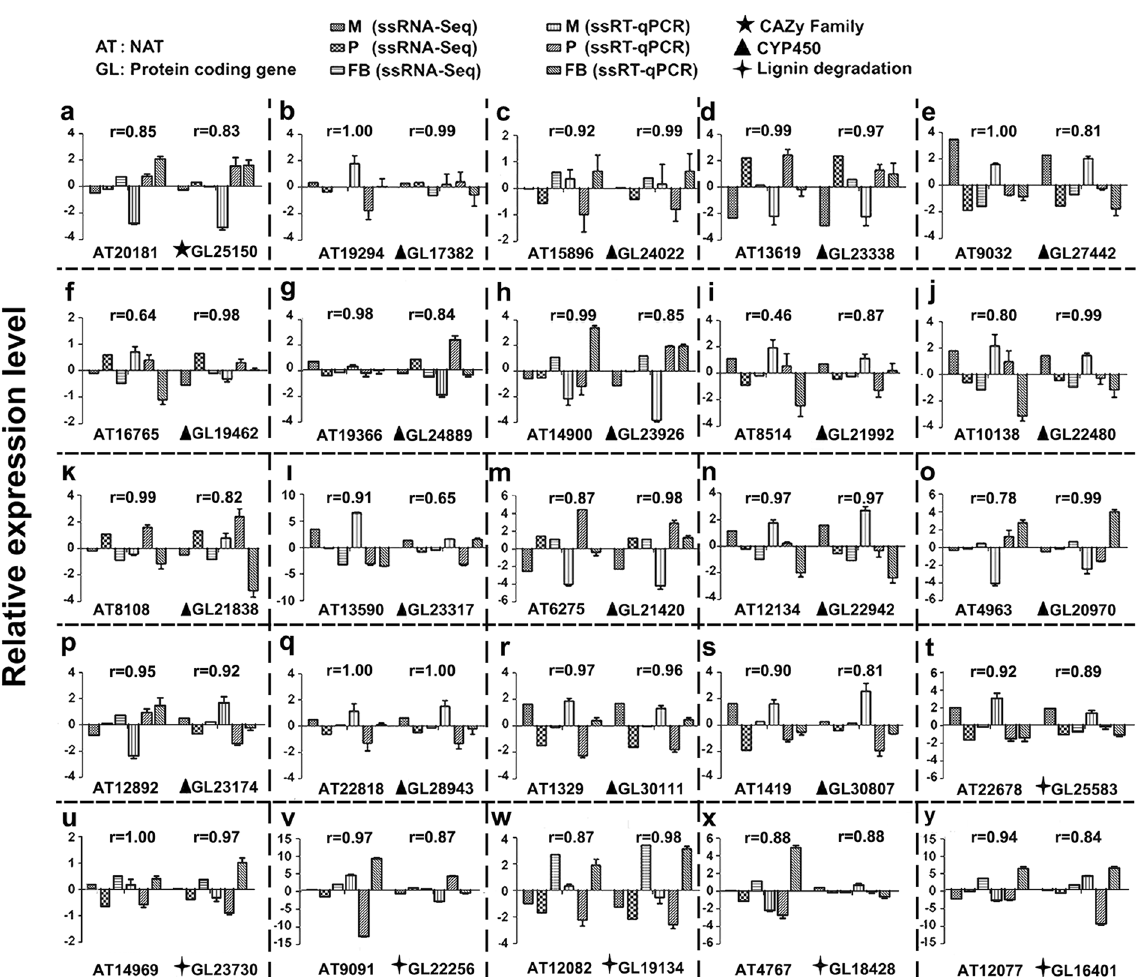
Figure 3. Validation of ssRNA-seq results with ssRT-qPCR experiments. Twenty-five SAT pairs were selected and subjected to ssRT-qPCR analysis. The expression levels obtained from the ssRNA-seq and ssRT-qPCR experiments for these SAT pairs are shown in panels a-y respectively. For results from both experiments, the expression levels at each developmental stage were normalized to the mean expression levels across the three stages. In each panel, the names of the NAT and ST are shown at the bottom. The X axis indicates the conditions under which the expression levels were measured, including the developmental stages and technologies. The Y axis indicates the relative expression levels obtained from the ssRNA-seq and ssRT-qPCR experiments. The error bar for the ssRT-qPCR results corresponds to the variations among the three biological replicates, each of which has three technical replicates. The gene families to which the STs belong were indicated in front of the gene names. The details of the genes can be found in Table S9. ▴ : CYP450; : Lignin degradation; ★ : CAZy family. M: mycelia; P: primordia; FB: fruiting